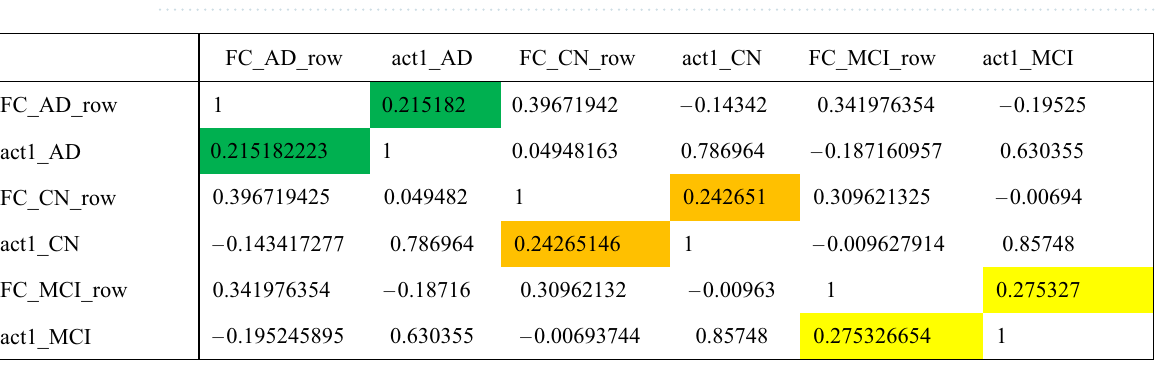
Table 5. Correlation matrix for weights as shown in Fig. 10. The colored ones are the highest measured value for the sample-parent pair, higher being better.